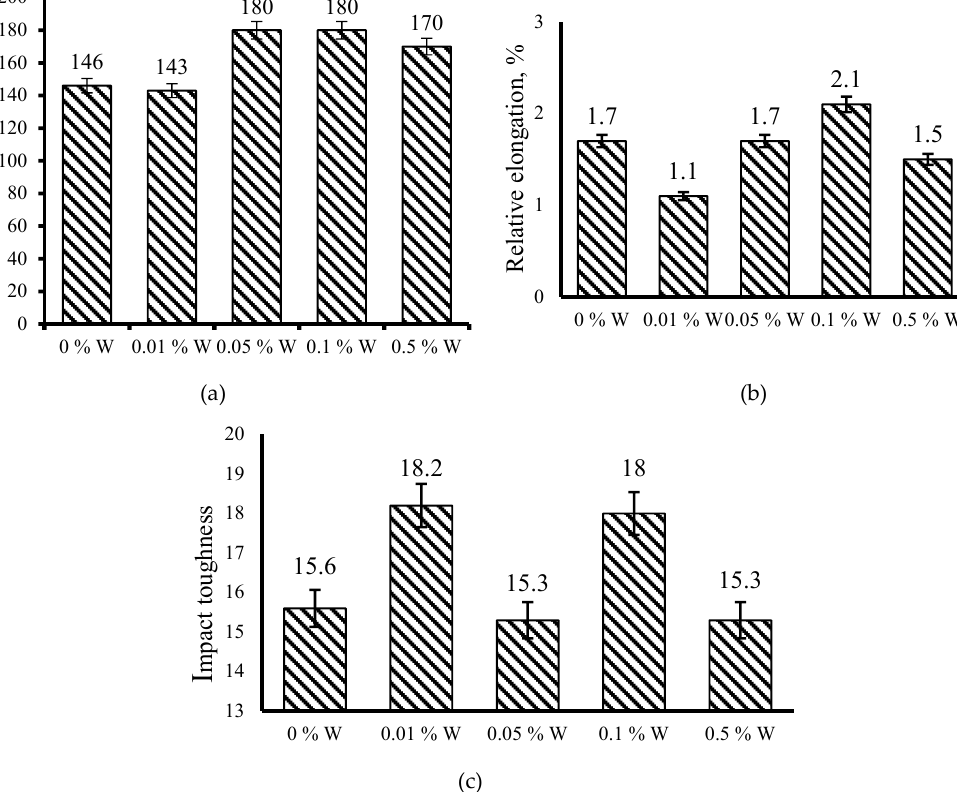
Figure 5. Influence of W nanopowder on properties of Al-12%Si alloy: ultimate tensile strength, MPa, ( a ); relative elongation, %, ( b ); impact toughness, ( c ).